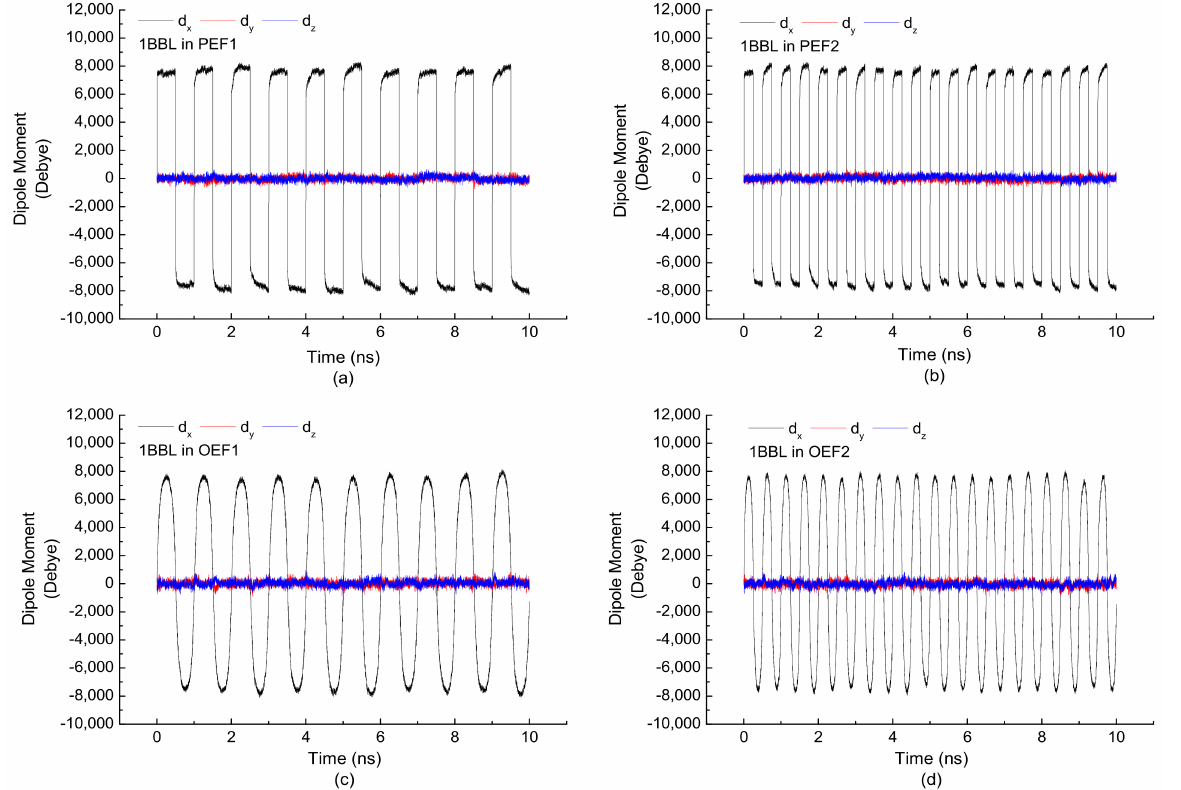
Figure 1. (Color online) Time evolution of three components of the dipole moment when the protein 1BBL is exposed in the ( a ) pulsed electric field with a frequency of 1000 MHz, ( b ) pulsed electric field with a frequency of 2000 MHz, ( c ) oscillating electric field with a frequency of 1000 MHz, and ( d ) oscillating electric field with a frequency of 2000 MHz, respectively.